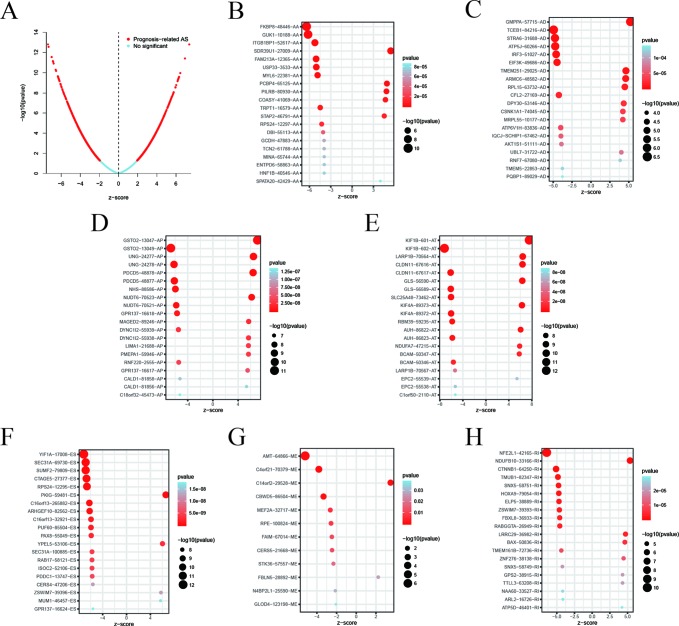
Top 20 most significant alternative splicing (AS) events in papillary renal cell carcinoma (pRCC). (A) Volcano plot demonstrating result of univariate Cox regression analysis, red dots represent survival-associated genes and blue dots represent irrelevant genes. The top 20 AS events correlated with clinical outcome based on alternate acceptor (AA) (B), alternate donor (AD) (C), alternate promoter (AP) (D), alternate terminator (AT) (E), exon skip (ES) (F), mutually exclusive exons (ME) (G), and retained intron (RI) (H). The value in the x-axis z-score is the coefficients of univariate cox regression analysis.